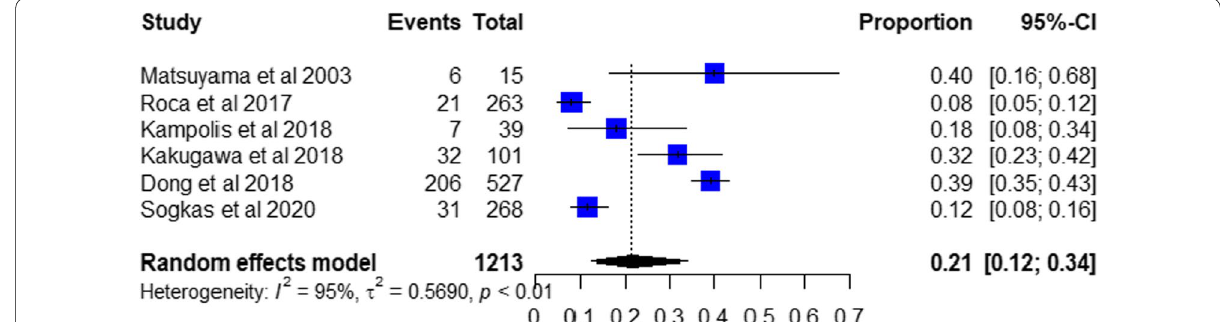
Fig. 4 Meta‑analysis of the General Interstitial Lung Disease in patients with Sjogren’s